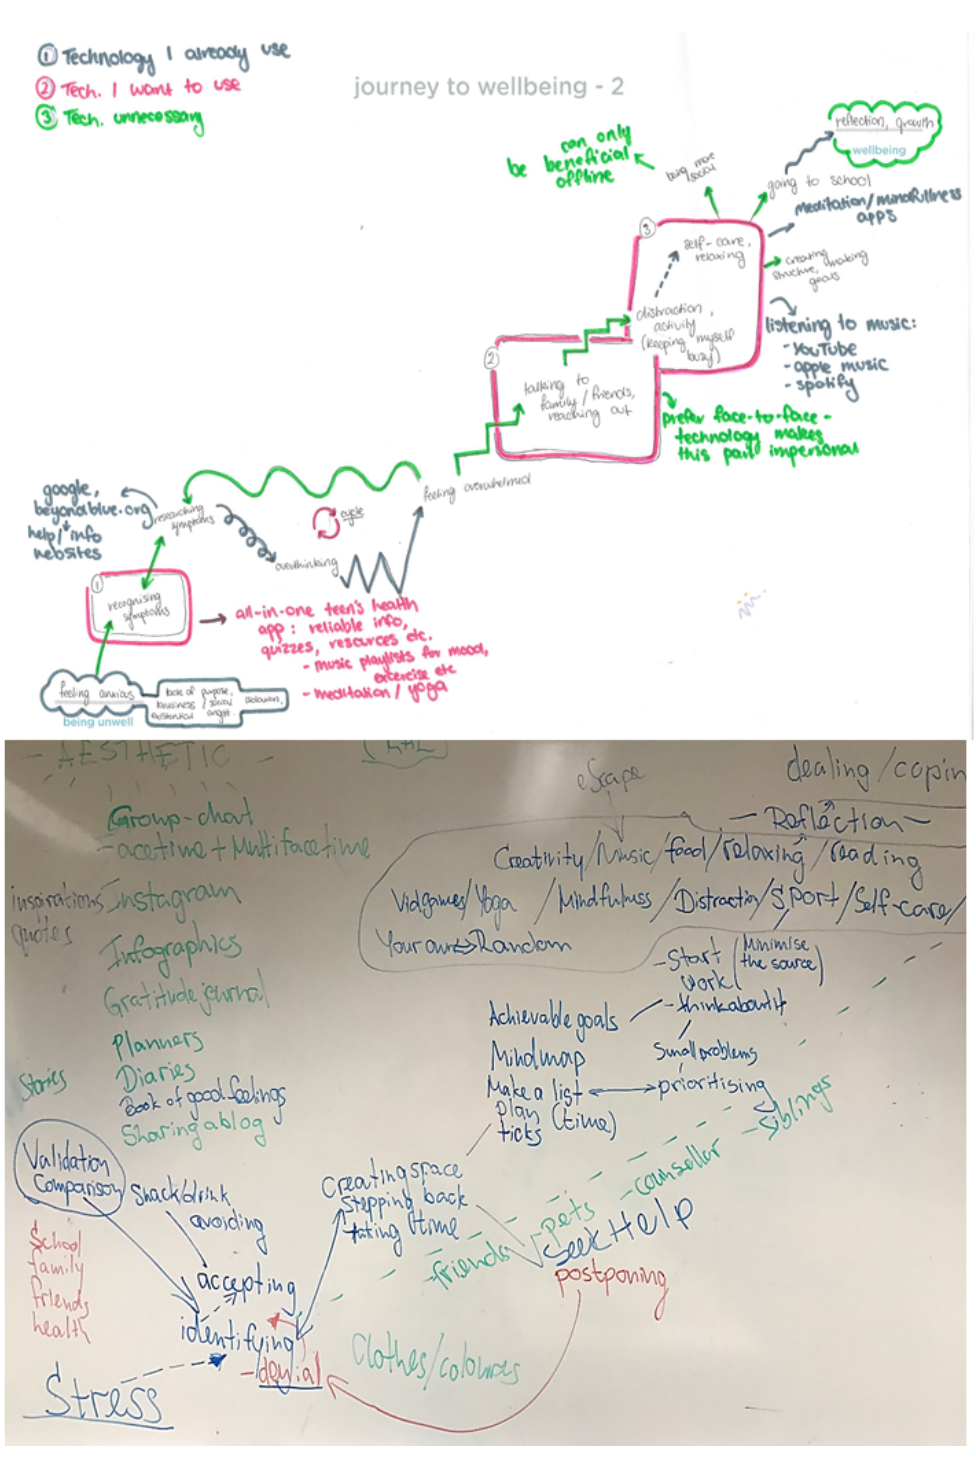
Figure 1. Individual and group journey